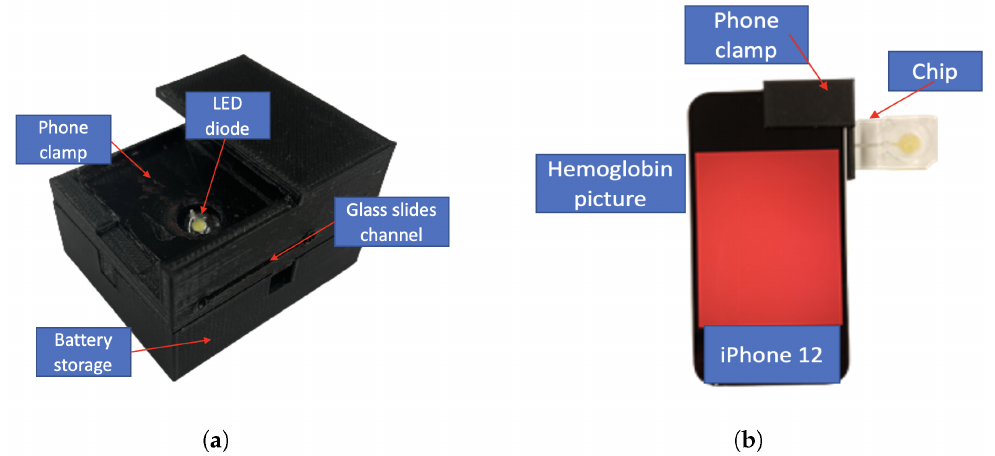
Figure 5. ( a ) 3D-printed portable phone clamp with LED diode mounted; ( b ) Actual photo taken when sliding the glass slide inside the